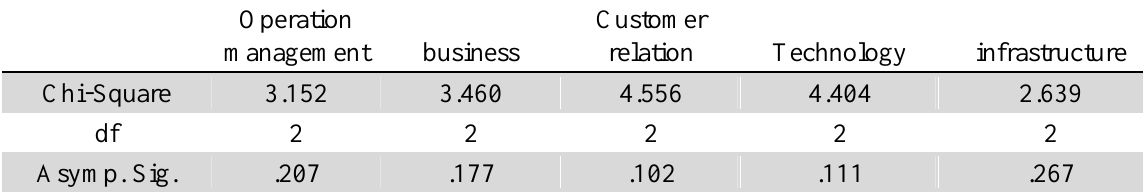
Kruskal-Wallis test